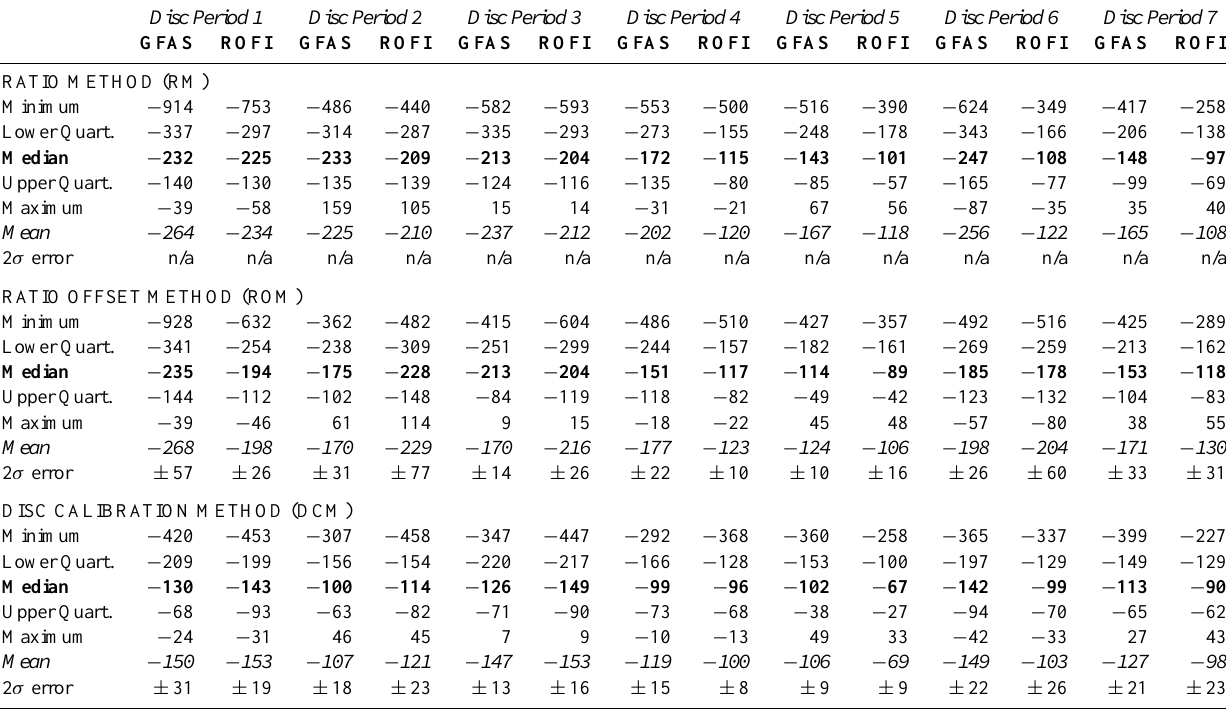
Table 2. Basic statistics for each disc period for all methods RM, ROM, DCM for both GFAS and ROFI analysers, using paired samples only. Median values in bold and mean values in italic. 2 σ error is the mean error for that disc period based on the standard deviation in the regression parameter fit. All values are in units of ngm − 2 s −